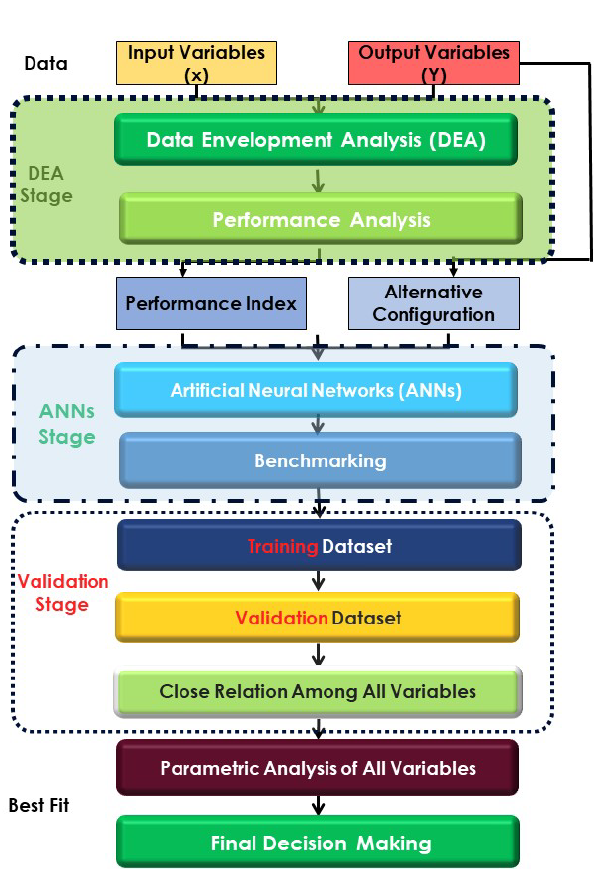
Figure 3. Flowchart of research methodology .